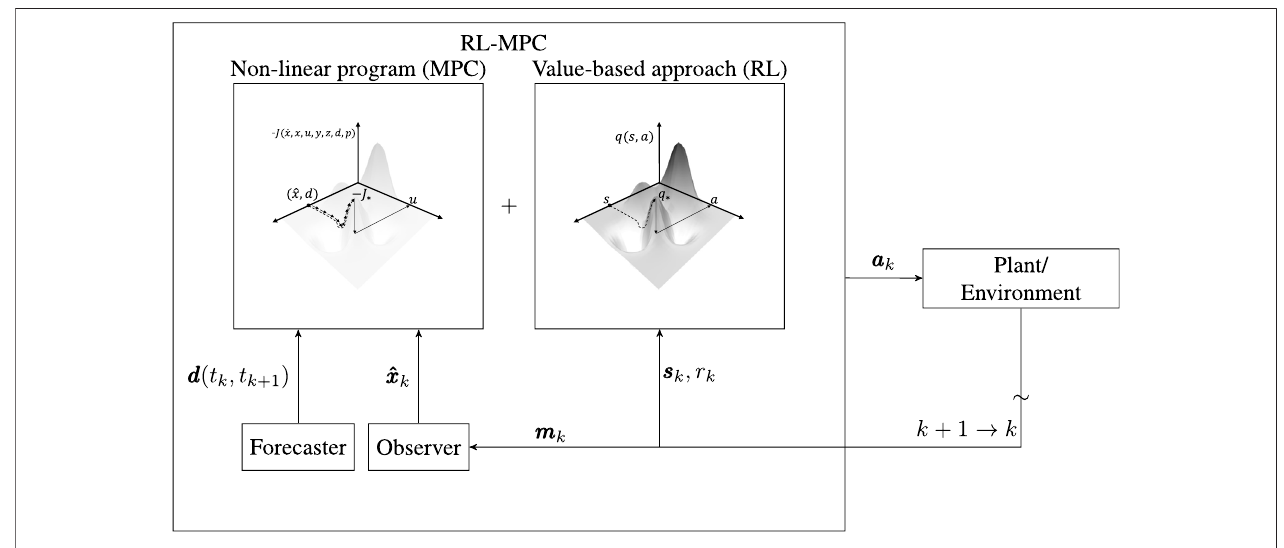
FIGURE 6 | Block diagram showing a high-level introduction of RL-MPC. Every control step, RL-MPC decides an action a k by optimizing the sum of the one-step ahead non-linear program of the MPC and the value function from the estimated following state (Arroyo et al., 2022).